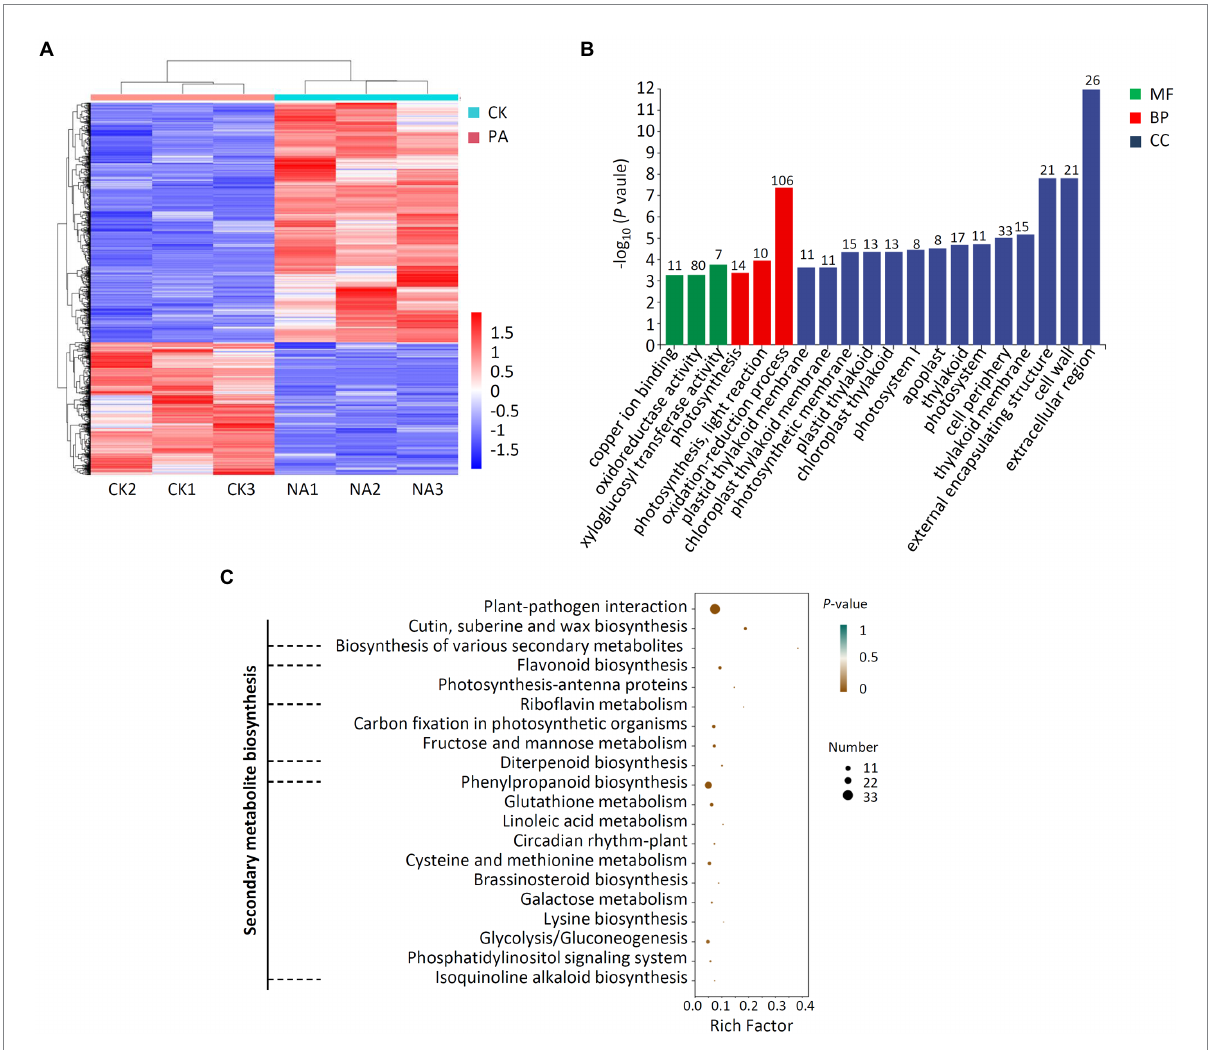
FIGURE 11 Analysis of DEG transcriptomes in apple fruit treated with B. halotolerans strain Pl7. (A) Heat map analysis. PA, apple fruit treated with strain Pl7; CK, untreated apple fruit. Gene expression levels are shown in red and blue, respectively. (B) DEG annotated GO analysis. The quantity of DEGs was marked above the column. CC, cellular components; BP, biological processes; MP, molecular functions. (C) DEG enrichment studies. Rich factor was the DEGs number/total genes found in the transcriptome of a specific activity.